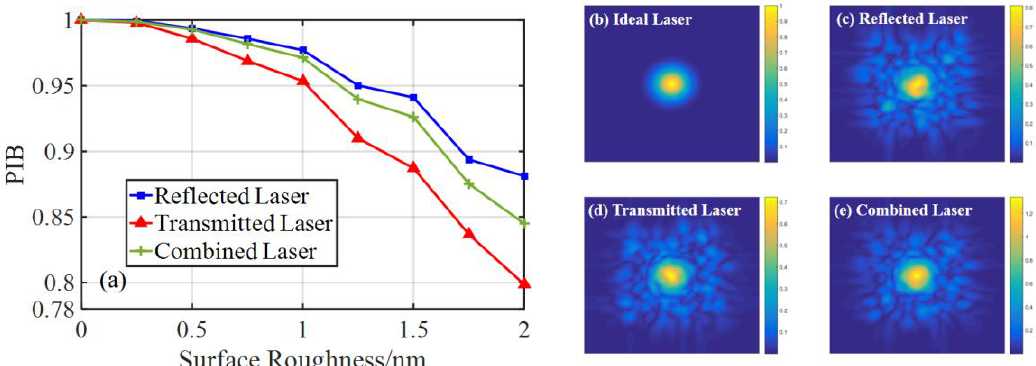
Figure 9. ( a ) The encircled power versus surface roughness at a distance of 500 mm. The intensity profile of: ( b ) the ideal laser (surface roughness σ = 0 nm); ( c ) the reflected laser (surface roughness σ = 2 nm); ( d ) the transmitted laser (surface roughness σ = 2 nm), and ( e ) the combined laser (surface roughness σ = 2 nm), all at a distance of 500 mm.